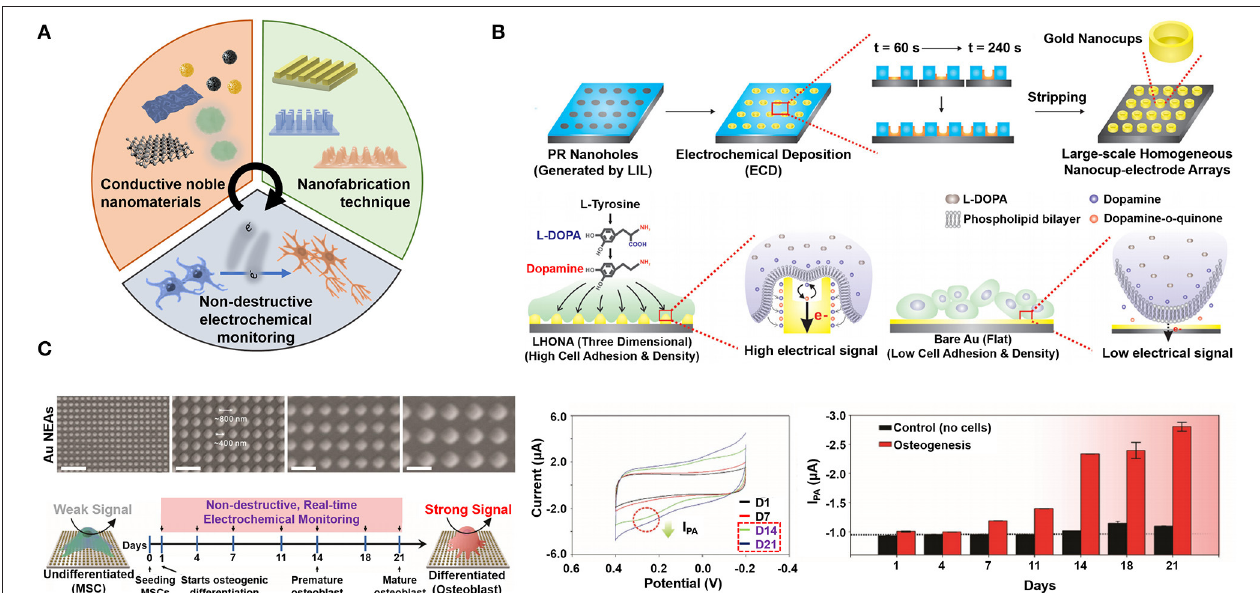
FIGURE 2 | (A) Schematic diagram for properties and components of metallic nanoarray-mediated non-destructive monitoring of stem cell differentiation based on electrochemical technique. (B) Schematic diagram of LHONA fabrication on the ITO electrode using the LIL and electrochemical deposition method, and scheme for effective interaction between cells and the surface of nanocup-like structure compared to flat (2D) surface. Reproduced with permission from Kim et al. (2015b). Copyright (2015) John Wiley and Sons. (C) Scanning electron microscopy (SEM) images of NEAs after physical vapor deposition of the gold based on the pitch sizes in 400, 800, 1,200 and 1,600nm (40,000 × magnification), schematic diagram of electrochemical signal changes by osteogenic differentiation based on ALP expression, and cyclic voltammograms and calculated current values of non-destructive monitoring of osteogenic differentiation from 1 to 21 days. Reproduced with permission from Lee J.-H. et al. (2018). Copyright (2018) John Wiley and